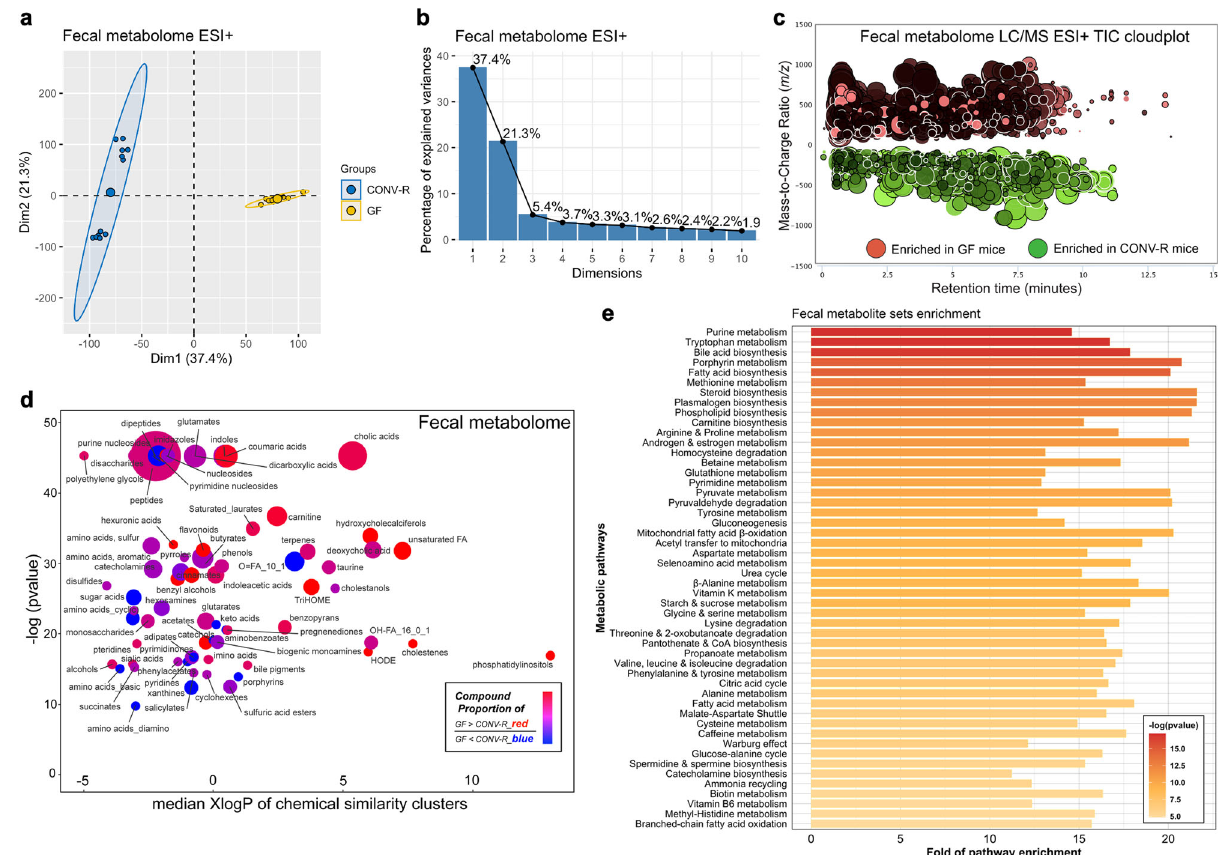
Fig. 2 Distinct fecal metabolome pro fi les owing to the presence of microbiota. a, b Principal component analysis score plot ( a ) and scree plot ( b ) for assessing fecal metabolomic data comparing GF ( N = 12) and CONV-R mice ( N = 12) under heated ESI + mode. c Metabolomic total ion chromatogram cloudplot of signi fi cant ion features in feces between groups ( p value < 0.01, fold change ≥ 1.5, two-sided Welch ’ s t test) using heated ESI + data as an example; larger circle size indicated larger fold change values ranging from 1.5 to 5300.6. d Chemical similarity enrichment analysis (ChemRICH) clustering of 533 identi fi ed altered fecal metabolites by chemical similarity with x -axis of mediation logarithmic additive octanol-water partition coef fi cients (XlogP) and y -axis for sets statistical signi fi cance based on the Kolmogorov – Smirnov test; the node size depicted total compound numbers for each cluster set and node color scale the proportion of GF-enriched vs. CONV-R enriched metabolites. e Quantitative metabolite set enrichment analysis (qMSEA) based on 99 a priori de fi ned sets of metabolites identi fi ed a total of 71 signi fi cantly perturbed fecal metabolic pathways (adjusted p < 0.05) with top 50 shown. Dim dimension, LC/MS liquid chromatography-mass spectrometry, TIC total ion chromatogram, TriHOME trihydroxyoctadecenoic acid, FA fatty acid, HODE hydroxyoctadecadienoic acid, CoA coenzyme